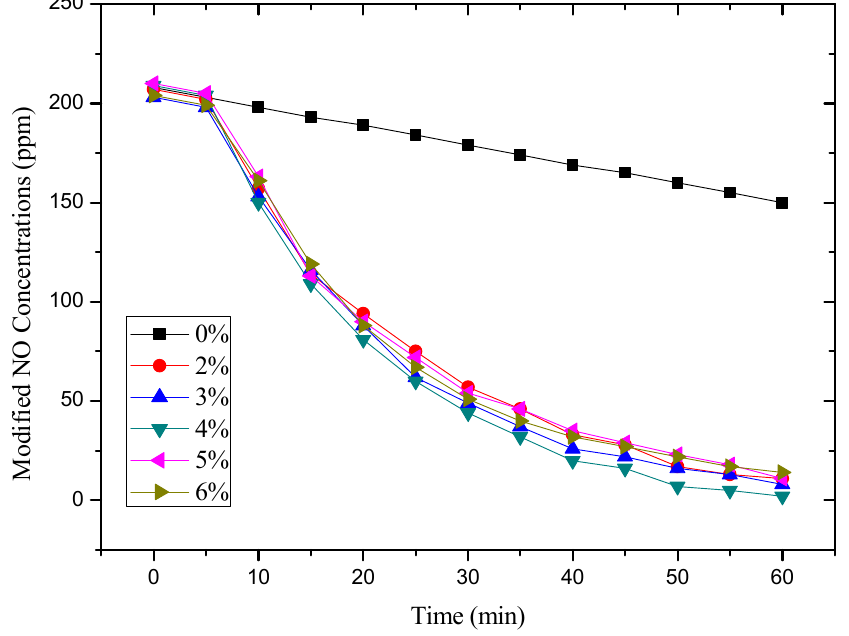
Figure 5. NO concentration variation with Nano-TiO 2 change.